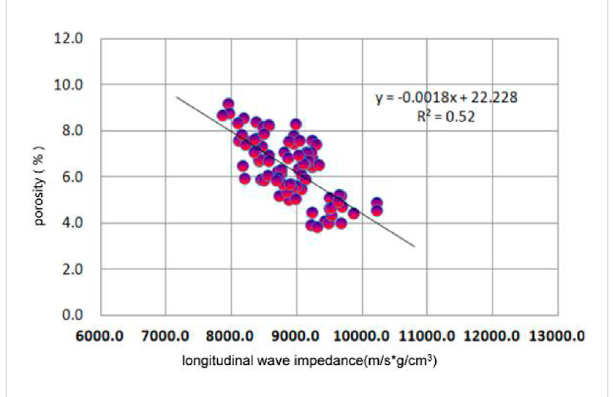
FIGURE 12 Cross plot of brittleness index and P-S wave velocity